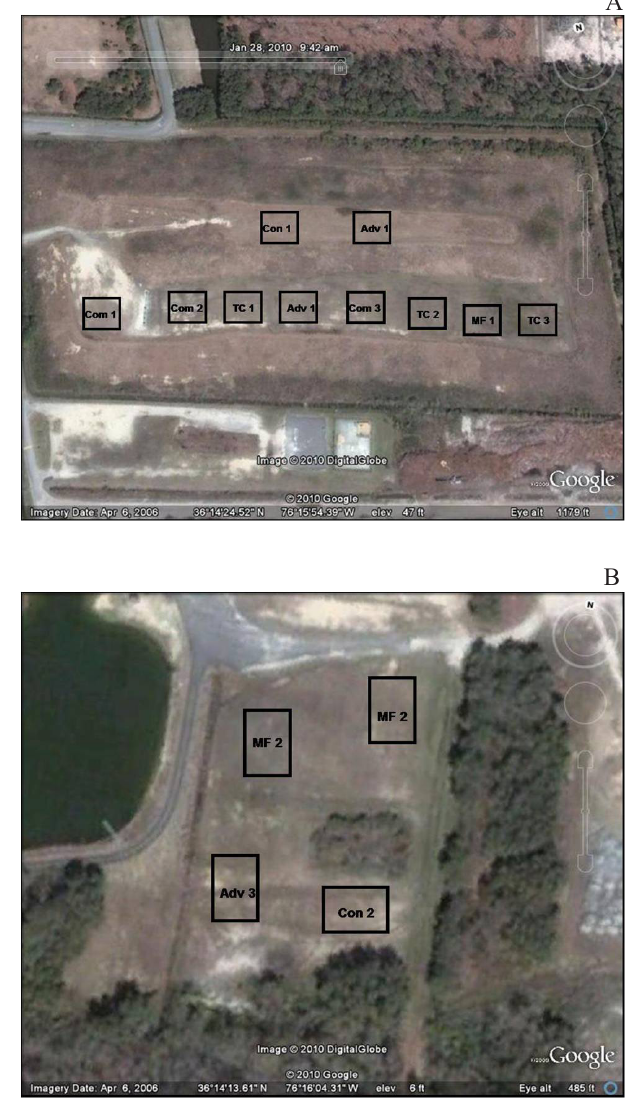
Fig. 1a-b. Placement of 1-year RIFA treatment plots located at Fun Junktion Park, Elizabeth City, NC (Google Earth 2010)- Advion ( Adv ), Top Choice ( TC ), MaxForce ( MF ), Advion /Top Choice combination ( Com ) and untreated control ( Con